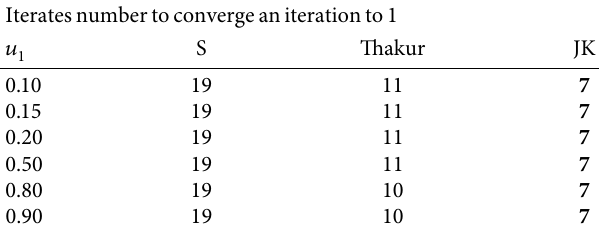
� √ � k / ( k + 5 ) 1/7 and β k � k